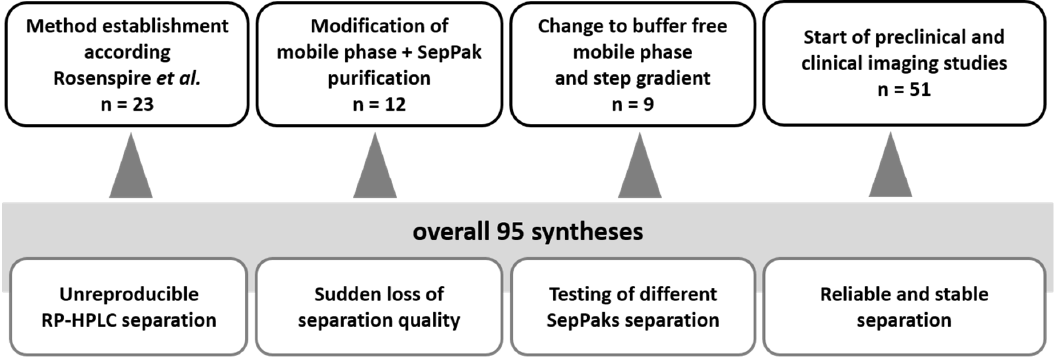
Figure 6. Overview on the radiosynthesis optimization, including the challenges and establishments during the first 44 syntheses and the stable separation process of the last 51 syntheses.